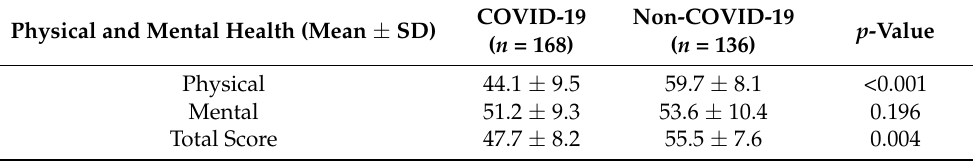
Table 4. The quality of life physical and mental scores based on the SF-12 survey results between COVID-19 positive and negative pregnant